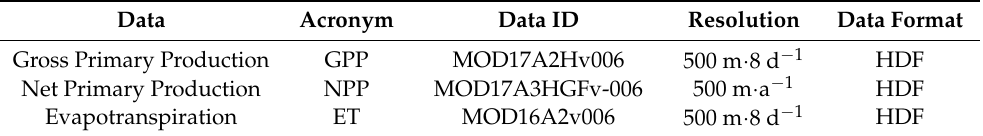
Table 1. MODIS data